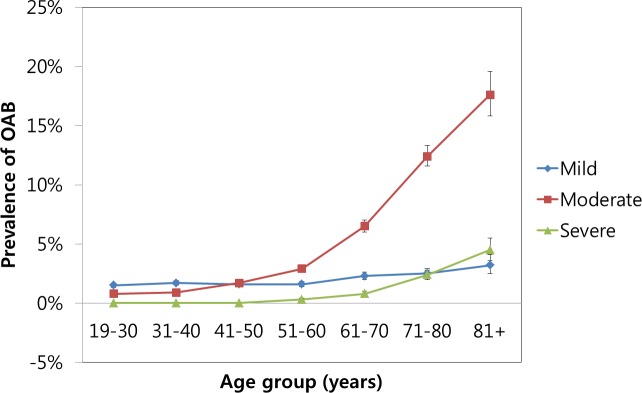
The prevalence of OAB increased with age.According to the severity of OAB, mild, moderate, and severe OAB were relatively comparable from 19–30 years of age through 41–50 years of age and steeply increased after 51 years of age.